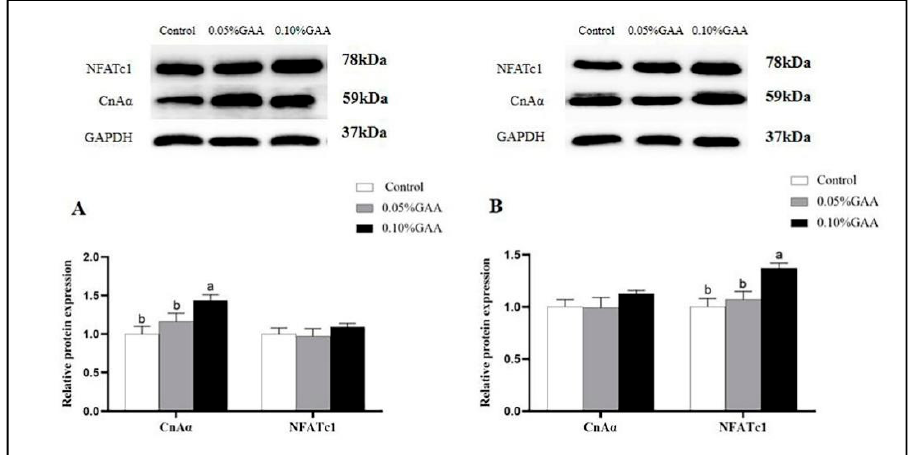
Figure 7. Effects of guanidinoacetic acid supplementation on the protein expressions of CnA α , NFATc1 of ( A ) longissimus thoracis muscle, and ( B ) semitendinosus muscle in finishing pigs. Means with different letters differ significantly ( p < 0.05). Values are presented as the mean ± SEM ( n = 5). Control: Finishing pigs were fed a basal diet; 0.05% GAA or 0.10% GAA: Finishing pigs were fed a basal diet supplemented with GAA at 500 or GAA at 1000 mg kg − 1 ; CnA α : Calcineurin catalytic subunit α ; NFATc1: Nuclear factor of activated T cells.